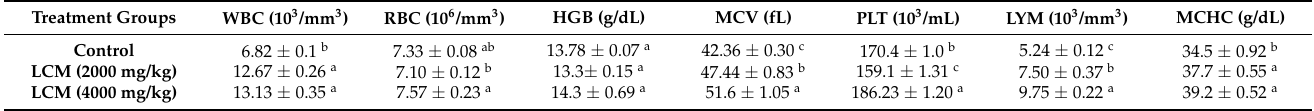
Table 3. Effect of different treatments with L. corymbulosum on hematological parameters.